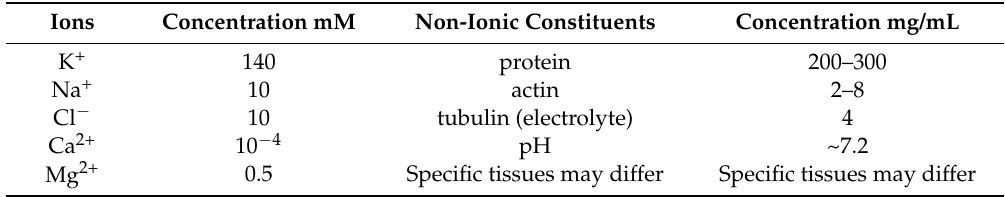
Table 1. Composition of the